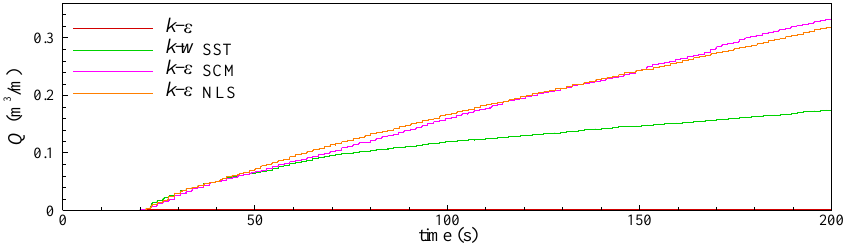
Figure 5. Time series of the wave overtopping discharge for the four turbulence models.